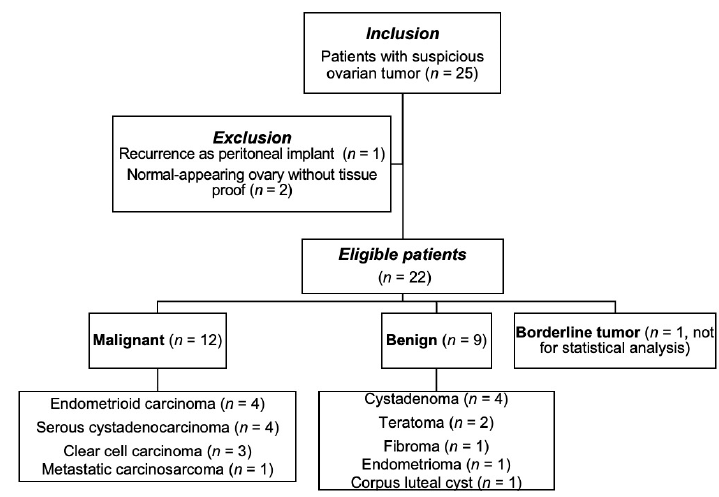
Figure 1. Flow diagram of patients and studies.